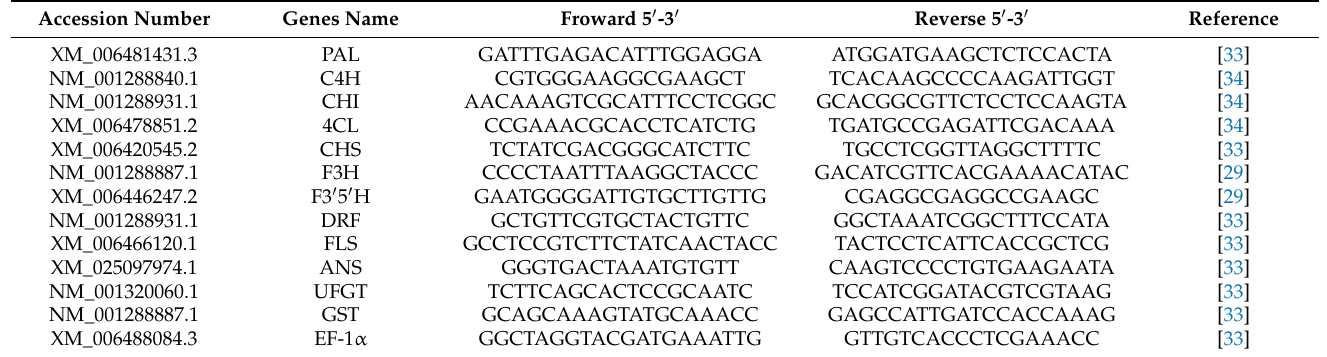
Table 1. Specific primers for quantitative real-time